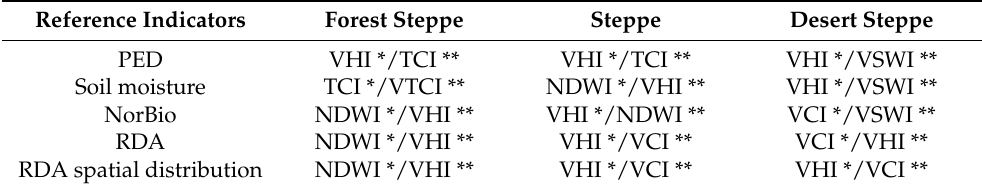
Table 6. Sensitivity of RS-derived drought indices to the reference indicators Reference